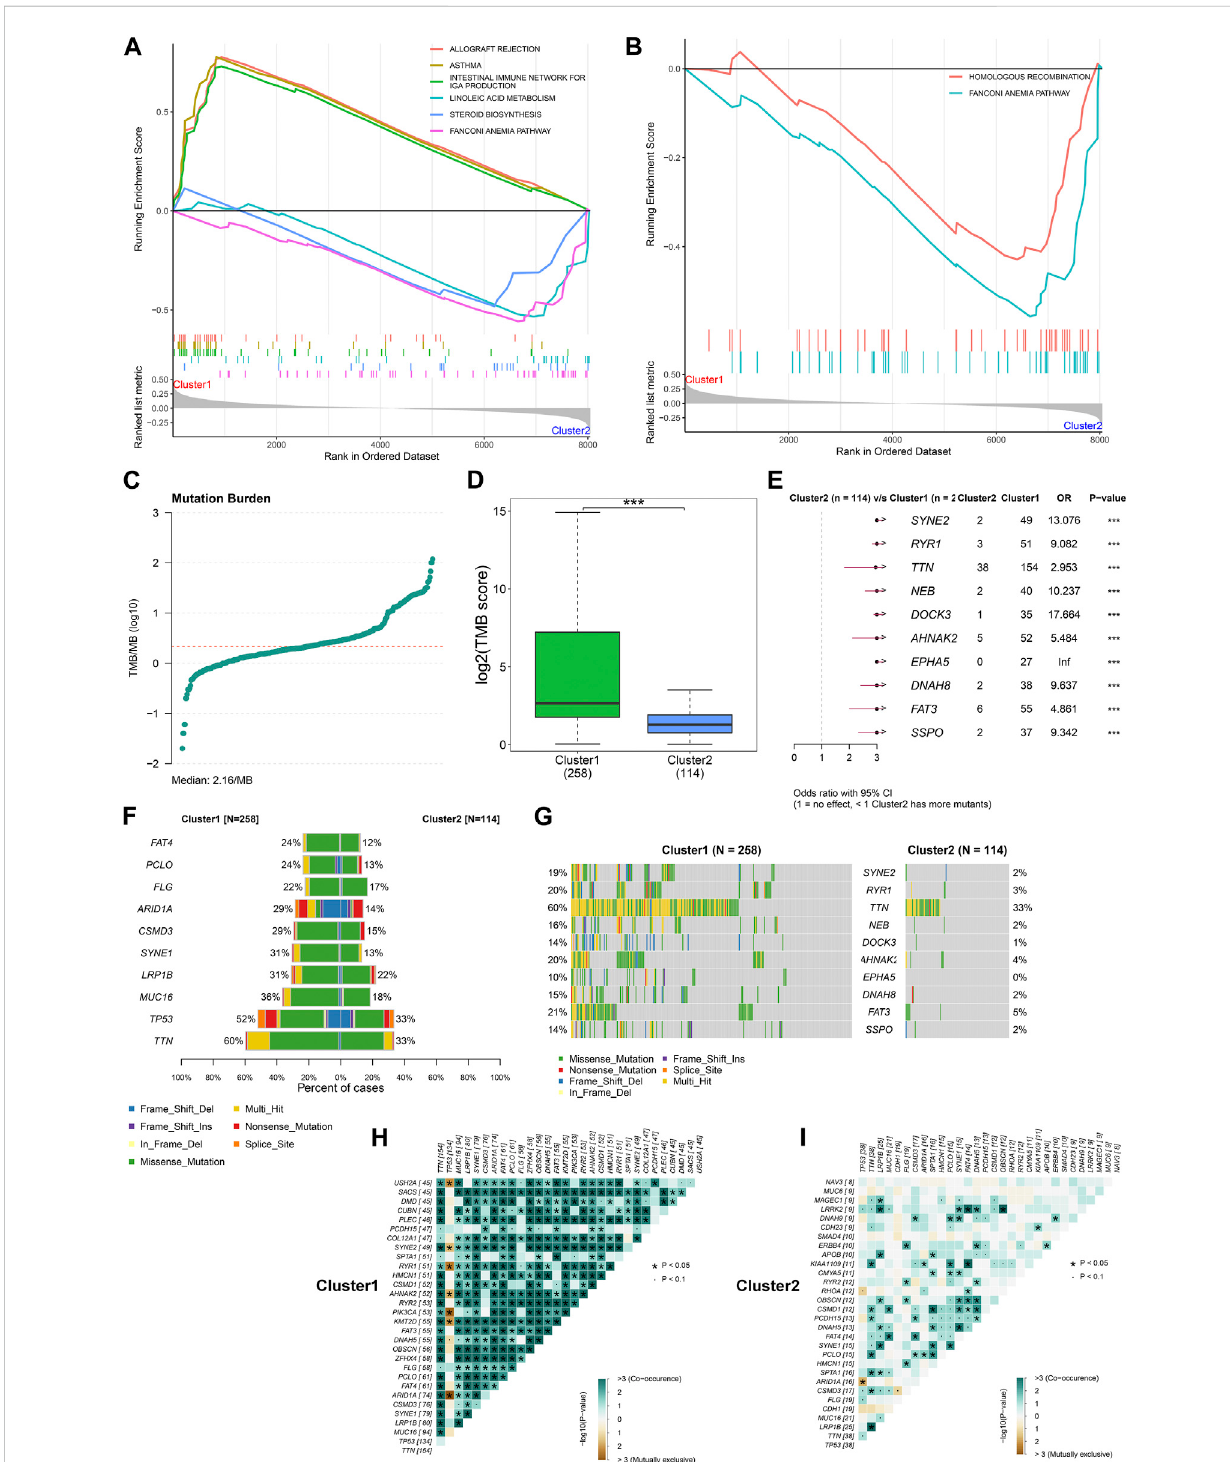
FIGURE 2 Differencesinsignaling pathways andsomaticmutationbetweenthetwoDNAdamagerepair-basedsubtypesacross TCGA-STAD. (A) GSEA forthe enrichment levels of signaling pathways in the two subtypes. For the enrichment score line chart, the horizontal axis denotes the sorted genes, and the verticalaxisdenotesthecorrespondingrunningenrichmentscore.Thepeakinthelinegraphistheenrichmentscoreofthegeneset,andthegenebefore thepeakisthecore geneunder thegeneset. Inthemiddleofthepanel, linesmarkgenes underthatgeneset. Thelowerpart ofthepanel shows the distribution of rank values for all genes. (B) GSEA for the enrichment levels of DNA damage repair pathways in the two subtypes. (C) Distribution of TMB score across TCGA-STAD. (D) Comparison of TBM score between subtypes. (E) Odd ratio (OR) of mutated genes between subtypes. OR > 1 denotes that cluster1hasmoremutantsthancluster2. (F,G) Thefrequencyofthetoptenmutatedgenesacrossthetwosubtypes. (H,I) Relationshipsbetweenmutated genes in cluster1 and cluster2,